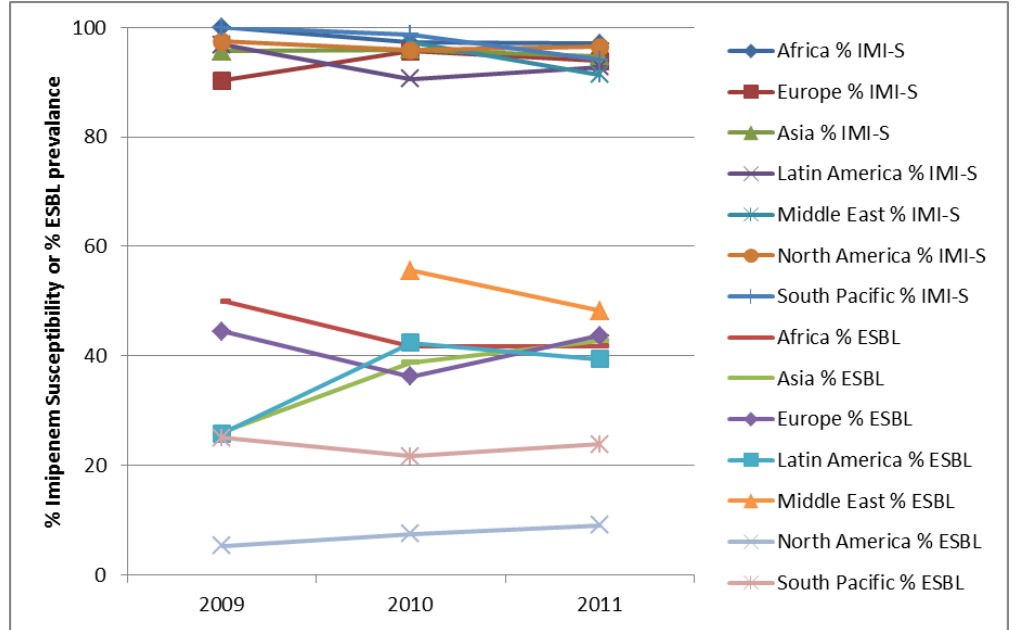
Figure 7. Susceptibility of K. pneumoniae from urinary-tract infections to imipenem (IMI-S) and prevalence of ESBLs by region from SMART 2009 to